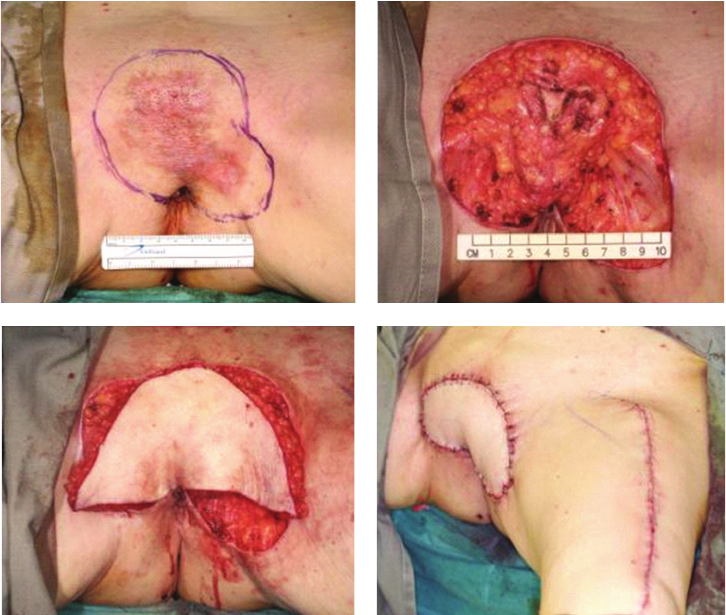
Figure 4: (Above, left) EMPD involving the pubic region. (Above, right) After resection, resultant defect measured 10 × 12 cm with underlying pubic ramus exposed. (Below, left) Pedicled anterolateral thigh perforator flap was harvested based on the perforators arising from the descending branch of lateral circumflex femoral artery. The flap then passed through a subcutaneous tunnel to reach the defect in the pubic region . (Below, right) Flap after inset and donor defect on the left thigh was closed